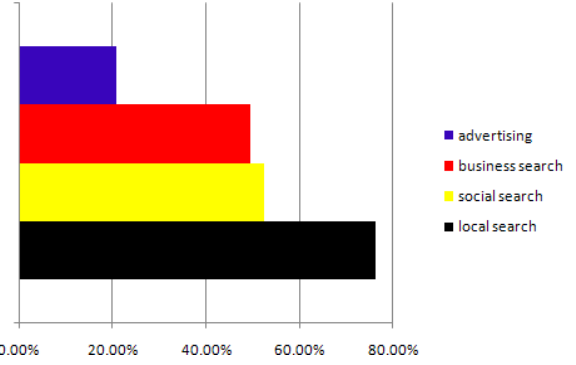
Figure 16. LBS market drivers according to students (the x-axis percentages show how many agreed that this is a potential significant LBS market driver in the near future).